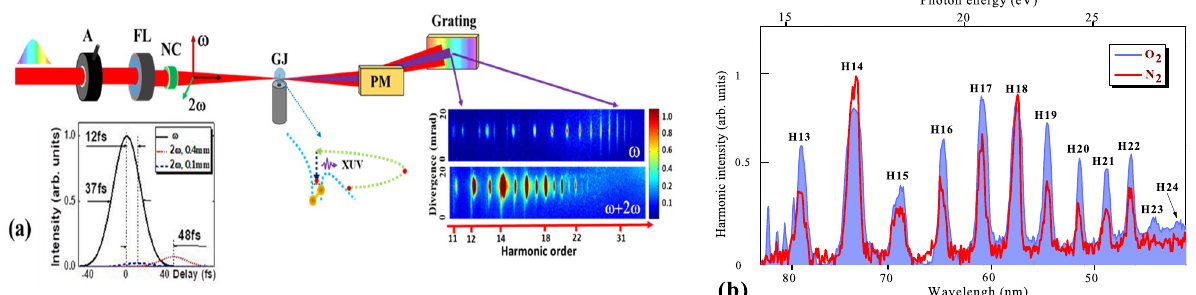
Figure 1. ( a ) Experimental arrangements for the generation of coherent XUV radiation using high-repetition rate near-infrared Yb fiber laser source. The laser pulses were propagated through the variable aperture iris (A) and focused by focusing lens (FL) onto the gas jet (GJ). The nonlinear crystal (NC) was inserted on the path of laser beam inside the vacuum chamber. The generated harmonics were analyzed using an XUV spectrometer with gold-coated plane mirror (PM) and flat field grating. The harmonic spectra were collected by CCD camera. The graph beneath optical axis shows the temporal map of separated pulses after propagation through different nonlinear crystals ( λ 1 = 1030 nm, black curve; λ 2 = 515 nm, blue dashed curve in the case of 0.1 mm thick BBO and red dotted curve in the case of 0.4 mm thick BBO). The scheme beneath the gas jet depicts the